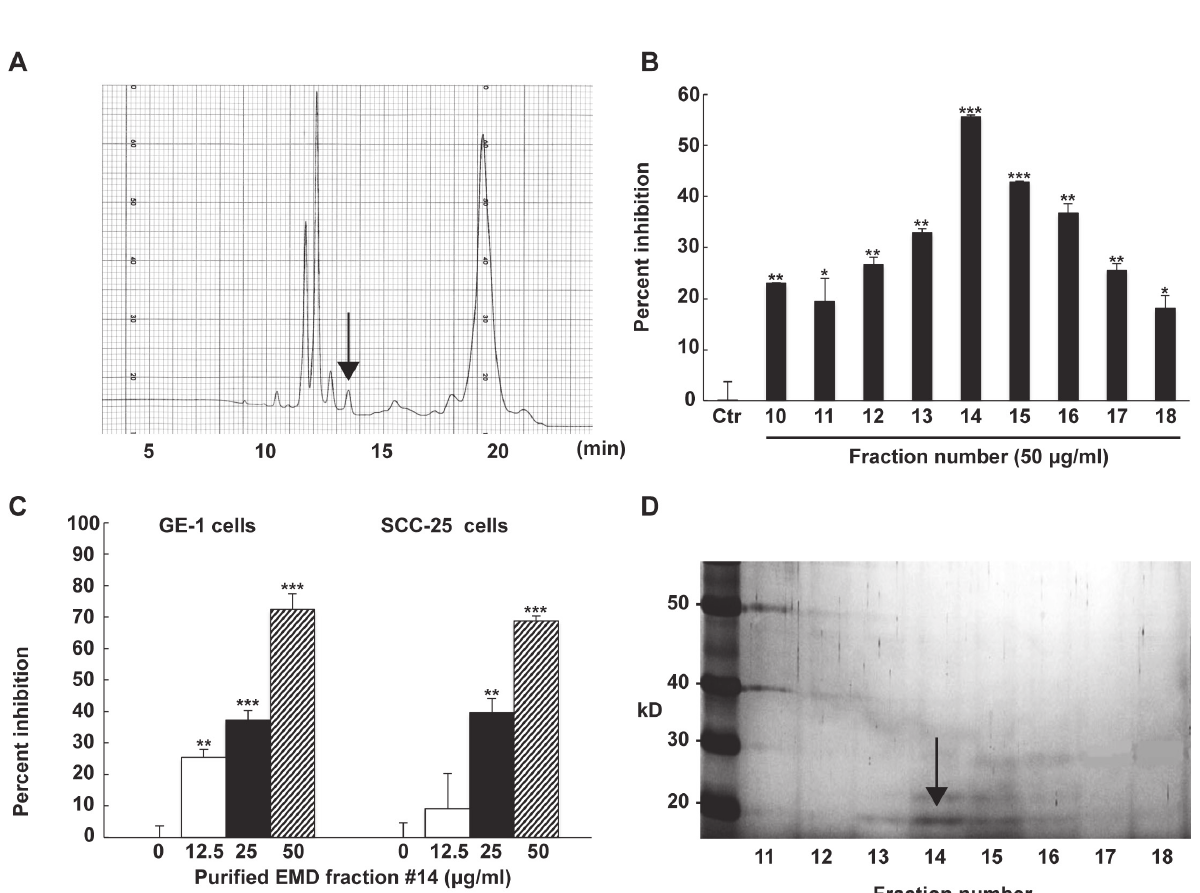
Figure 1- Effects of purified enamel matrix derivative (EMD) fractions on epithelial cell proliferation. (A) Results of reversed- phase high-performance liquid chromatography (HPLC) using C18 hydrophobic support. Lyophilized EMD was dissolved in 0.1% TFA, applied to reversed-phase HPLC, and eluted at 0.5 mL/minute. The arrow indicates the bioactive peak; (B) GE-1 cells were stimulated with each fraction (50 μg/mL) for 48 hours. Cell viability was determined using WST-1 analysis. The data show the percentage inhibition of cell proliferation from independent samples (n=3). The bars represent mean±standard deviation. Data was analyzed by Dunnett’s test after one-way ANOVA (*P<0.05, **P<0.01, ***P<0.0001 vs untreated control); (C) GE-1 and SCC-25 cells were separately cultured for 48 hours in the presence of 0-50 μg/mL